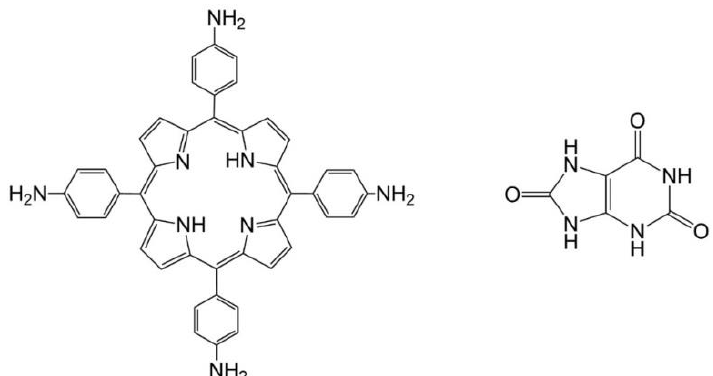
Figure 1. The Structure of 5,10,15,20-tetrakis(4-amino-phenyl-)porphyrin, (TAmPP) and of uric acid (UA) in its lactam form. Table 1. Recently developed detection methods of uric acid. Sensitive materials, concentration ranges, and detection limits.